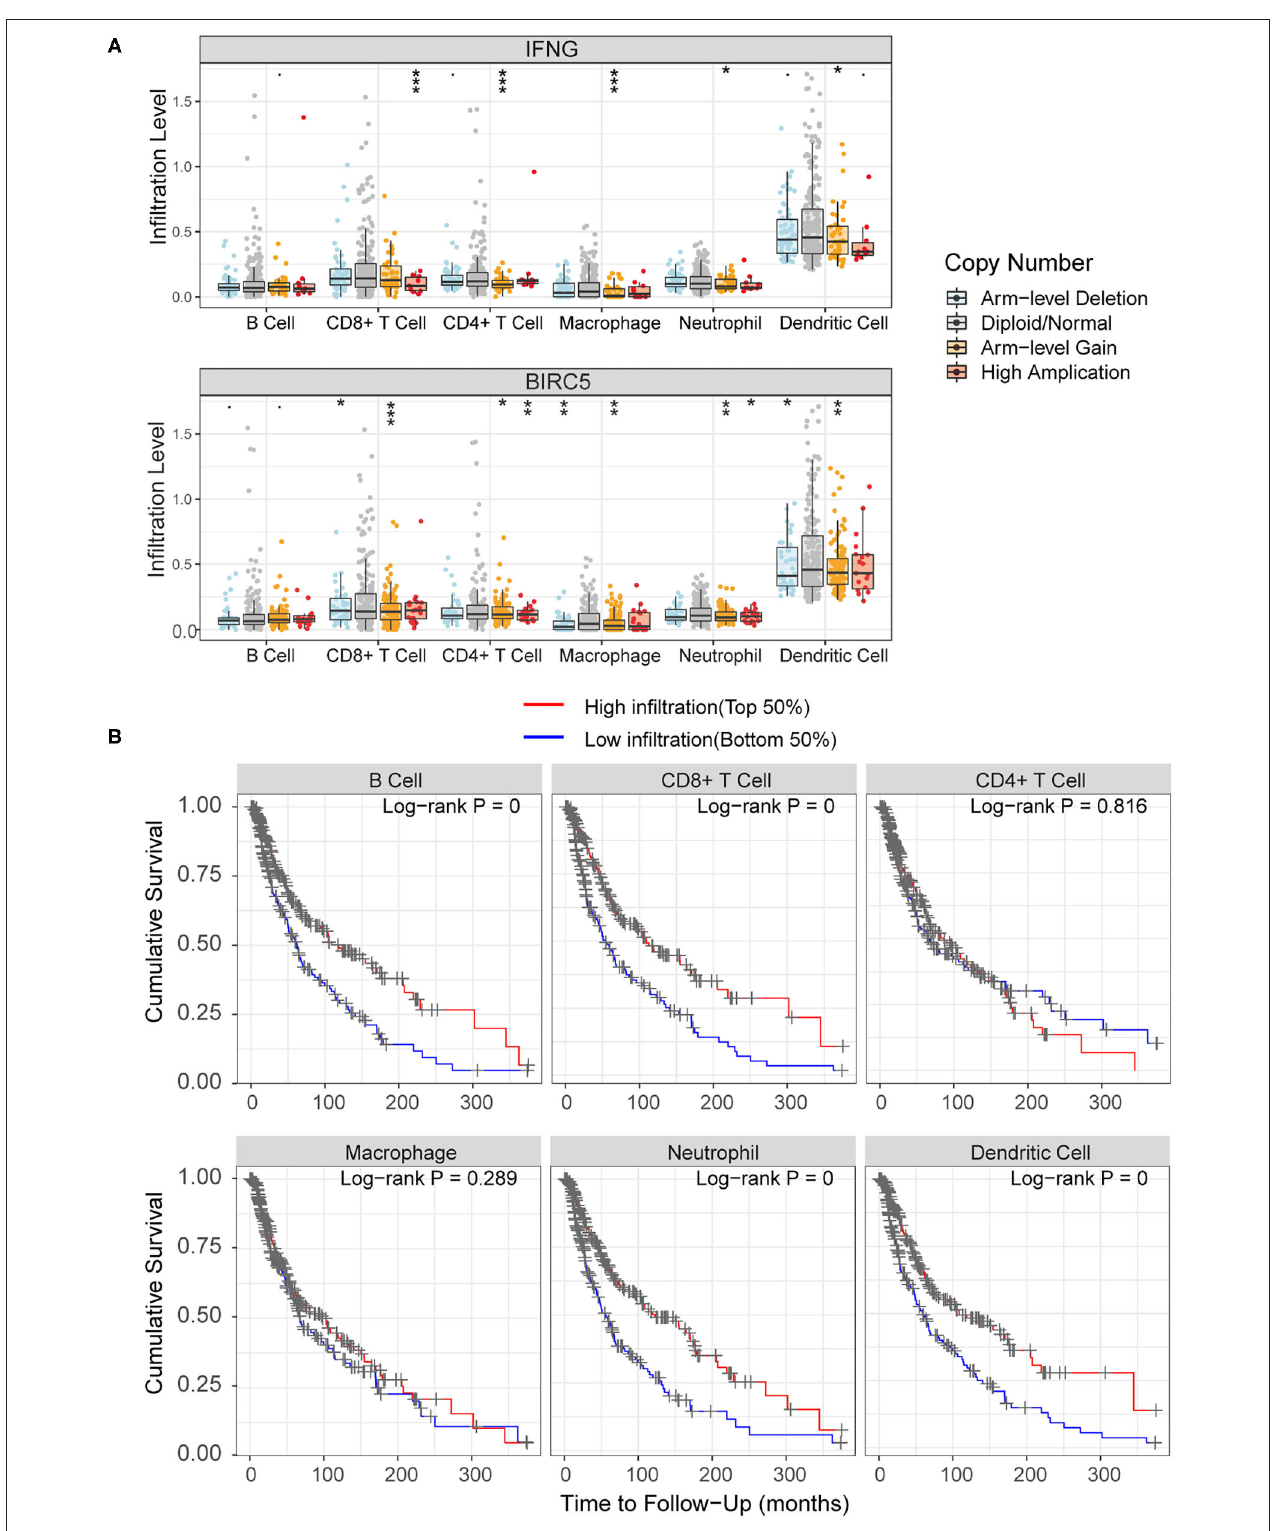
FIGURE 9 | Association of immune infiltration with hub genes and prognosis. (A) Comparisons of immune infiltration between sample with copy number alteration and diploid of IFNG and BIRC5 . (B) High infiltration level of B cell, CD8 + T cell, neutrophil and dendritic cell were associated with better survival outcomes. · P < 0.01; * P < 0.05; ** P < 0.01; *** P < 0.001.